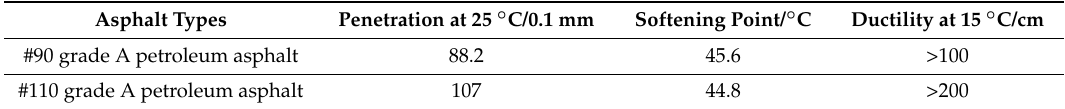
Table 1. Basic rheological properties of two asphalt